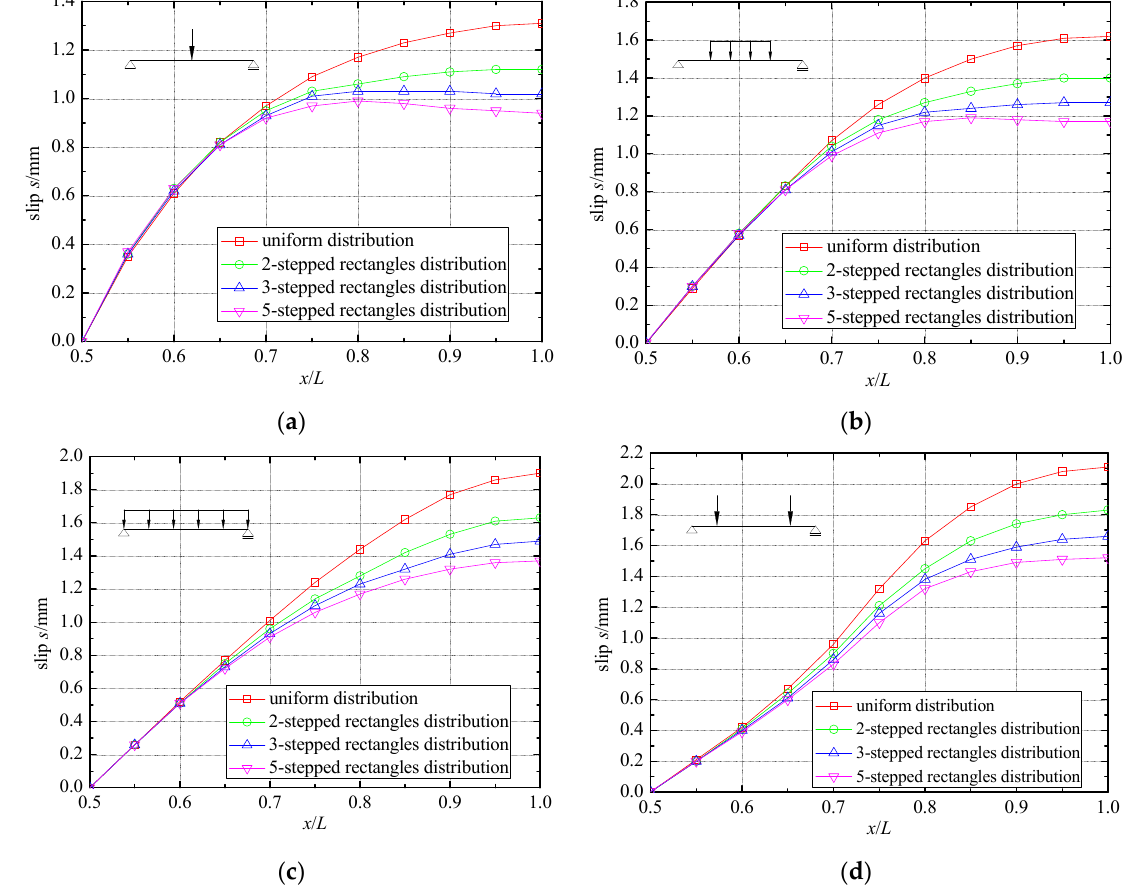
Figure 10. Comparison of interface slip under four different types of load. ( a ) point load at mid-span; ( b ) uniformly distributed load at mid-span; ( c ) uniformly distributed load; ( d ) two-point load